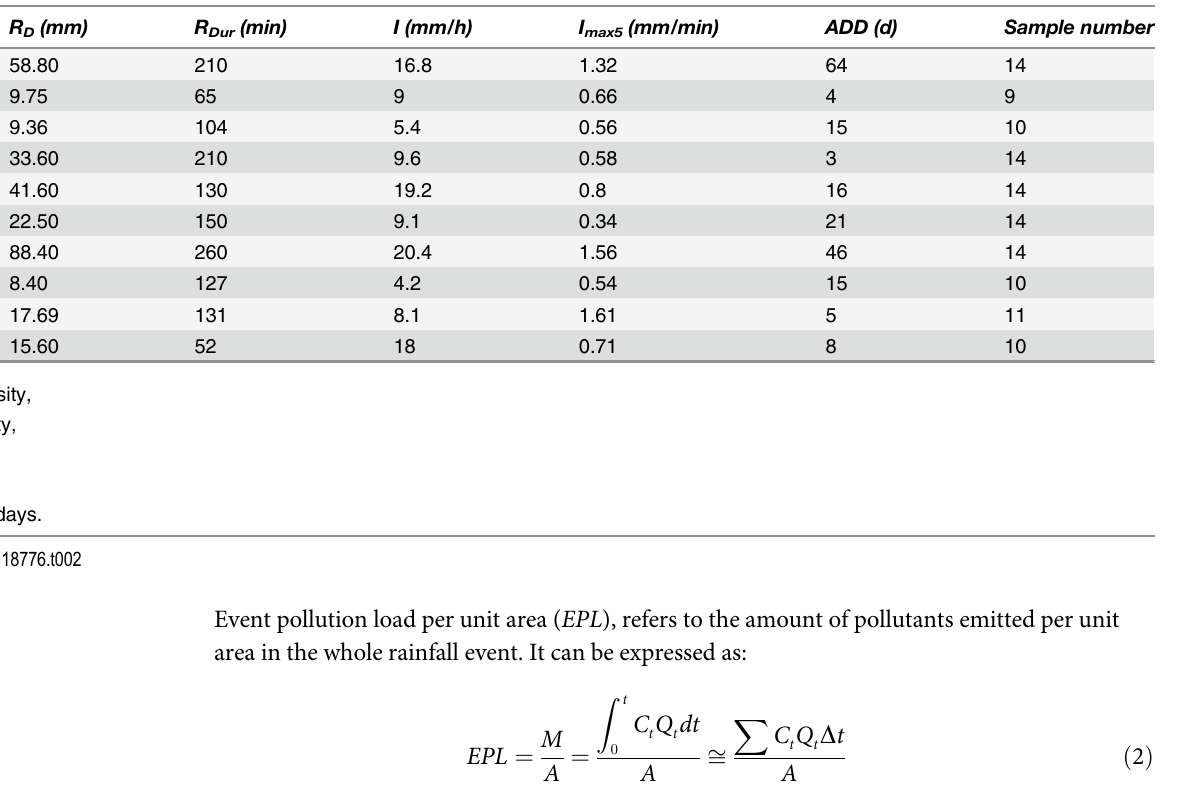
Table 2. Characteristics of the rainfall events ( n =